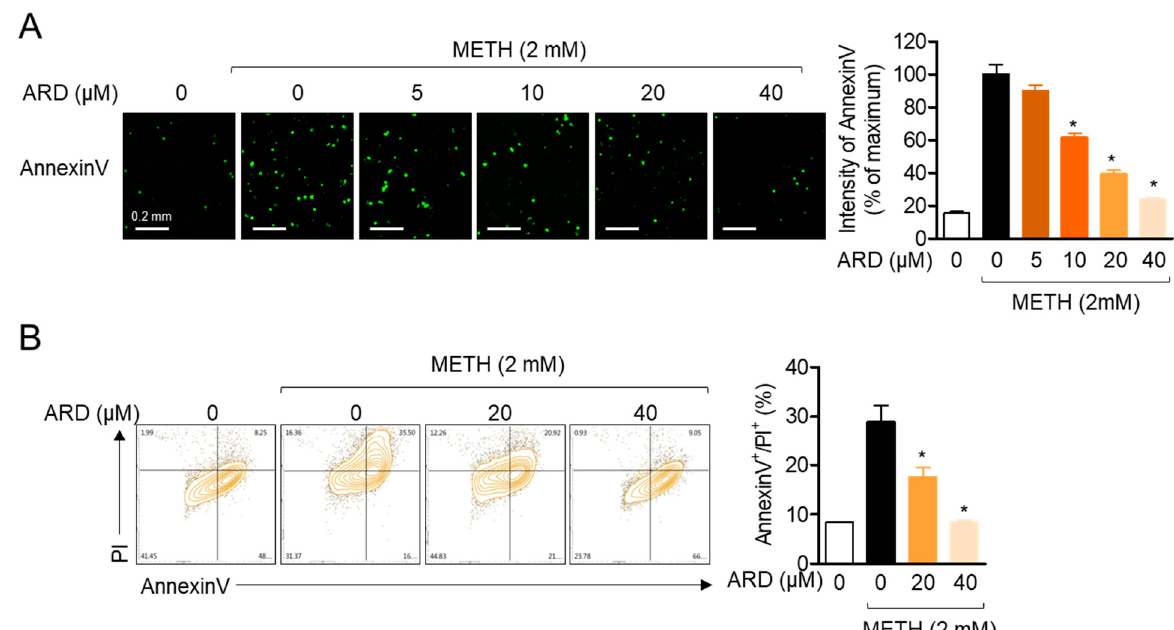
Figure 7. ( A ) SH-SY5y cells (5 × 10 3 /well, 96-well plate) stained with 1 × AnnexinV staining reagent were pre-treated with the indicated concentration (0 to 40 µ M) of aromadendrin for 1 h and exposed to 2mM METH for 24 h. AnnexinV was detected by IncuCyte ® imaging system, and the intensity of AnnexinV was calculated. ( B ) SH-SY5y cells were pre-treated with the indicated concentration (0 to 40 µ M) of aromadendrin for 1 h and exposed to 2 mM METH for 24 h. After collection, AnnexinV/PI apoptosis assay was performed by flow cytometry, and AnnexinV/PI-positive cells were presented in a bar graph. White bar indicates 0.2 mm. The mean value of three experiments ± SEM is presented. * p < 0.05 between METH-treated cells.